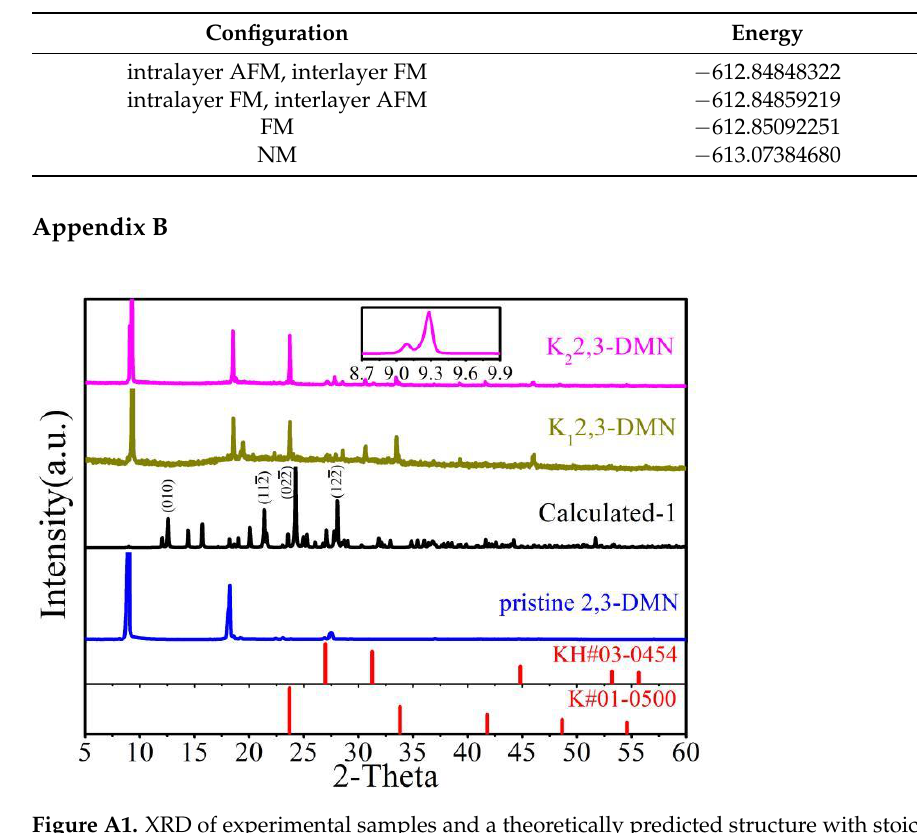
Figure A1. XRD of experimental samples and a theoretically predicted structure with stoichiometric ratio of 1:1. “Calculated-1” represents XRD data of the theoretical structure.